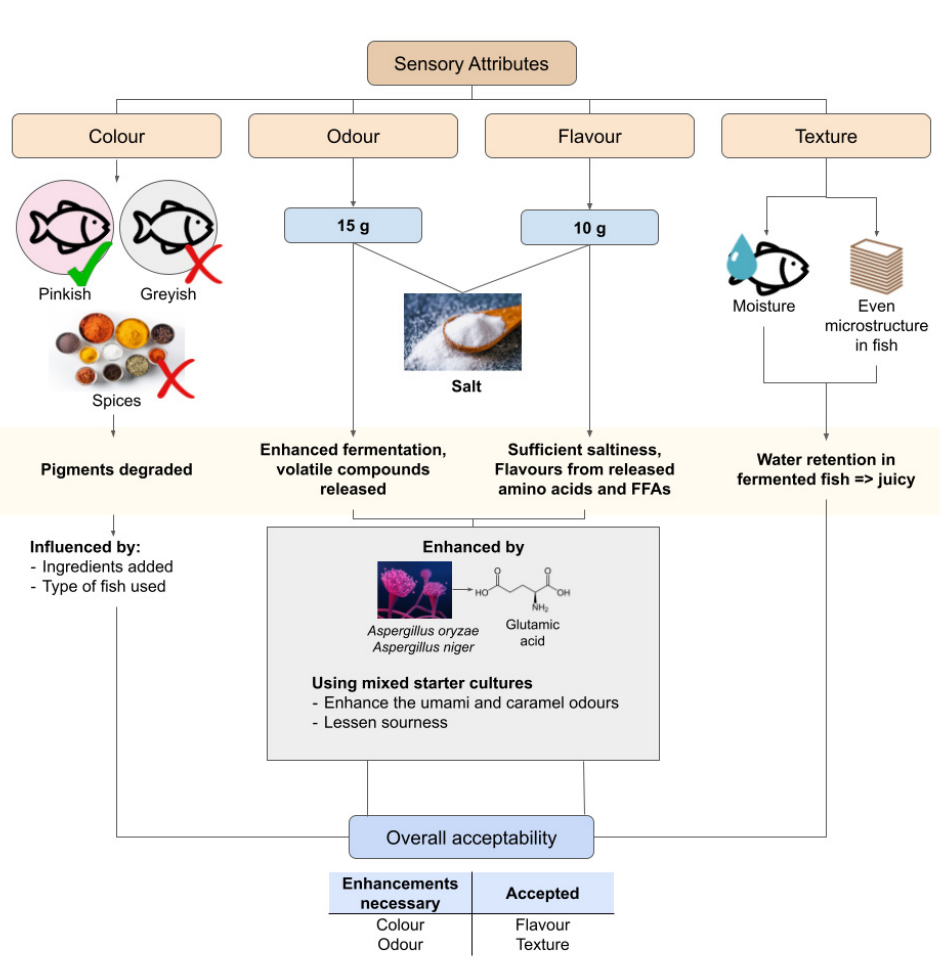
Figure 4. Summary of the sensory attributes of fermented fish in relation to their overall acceptability. As for the texture, it was reported that people felt that the textures in fish did not change significantly before and after fermentation [105]. However, the texture preference between different fermented fish products still exists. Products that had less moisture content or more water that osmotically flowed out of the fish were generally less liked, as was the uneven network of the microstructure in the fish [61]. This accounts for the juiciness of the fermented fish and how pleasurable it is to chew on the products (Figure 4). As such, the texture of fermented fish can be enhanced by focusing on the water content of the fish during fermentation. Generally, the acceptance of fermented fish products varies according to the colour, odour, texture, and flavour. From the study about som-fug, the fish fermented with 10 g of salt and pre-soaked in spices were the most accepted product compared with the ones fermented with 15 g of salt [106]. This is due to the previously discussed ingredient factor in the flavour aspect. Therefore, the sensory attributes of fermented fish, which can be altered and enhanced by the manipulation of the biochemical characteristics, greatly influence the acceptance of the products in the